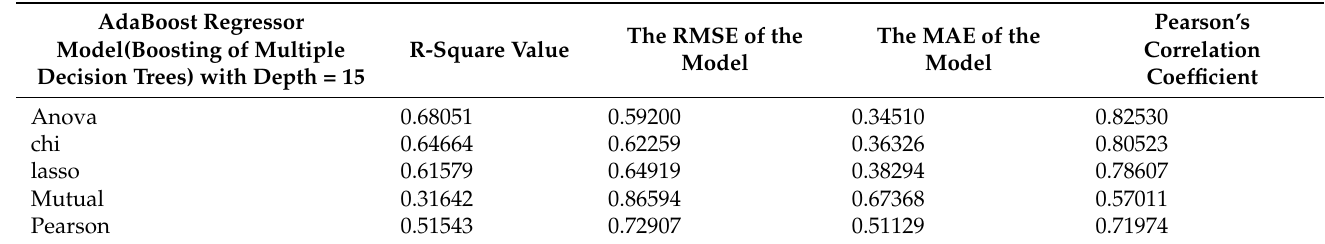
Table 7. AdaBoost Regressor.